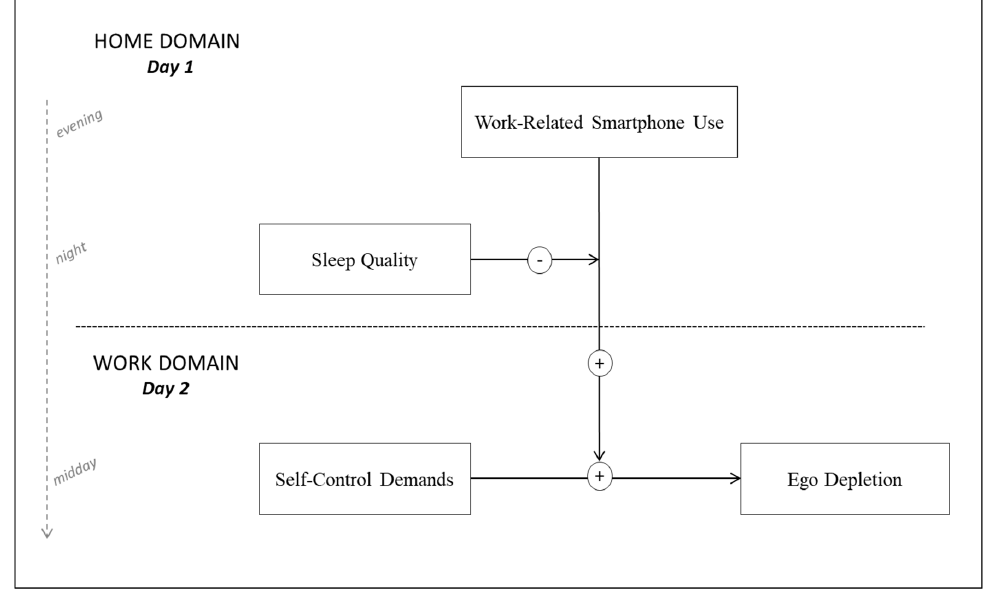
Figure 1. Research Model.